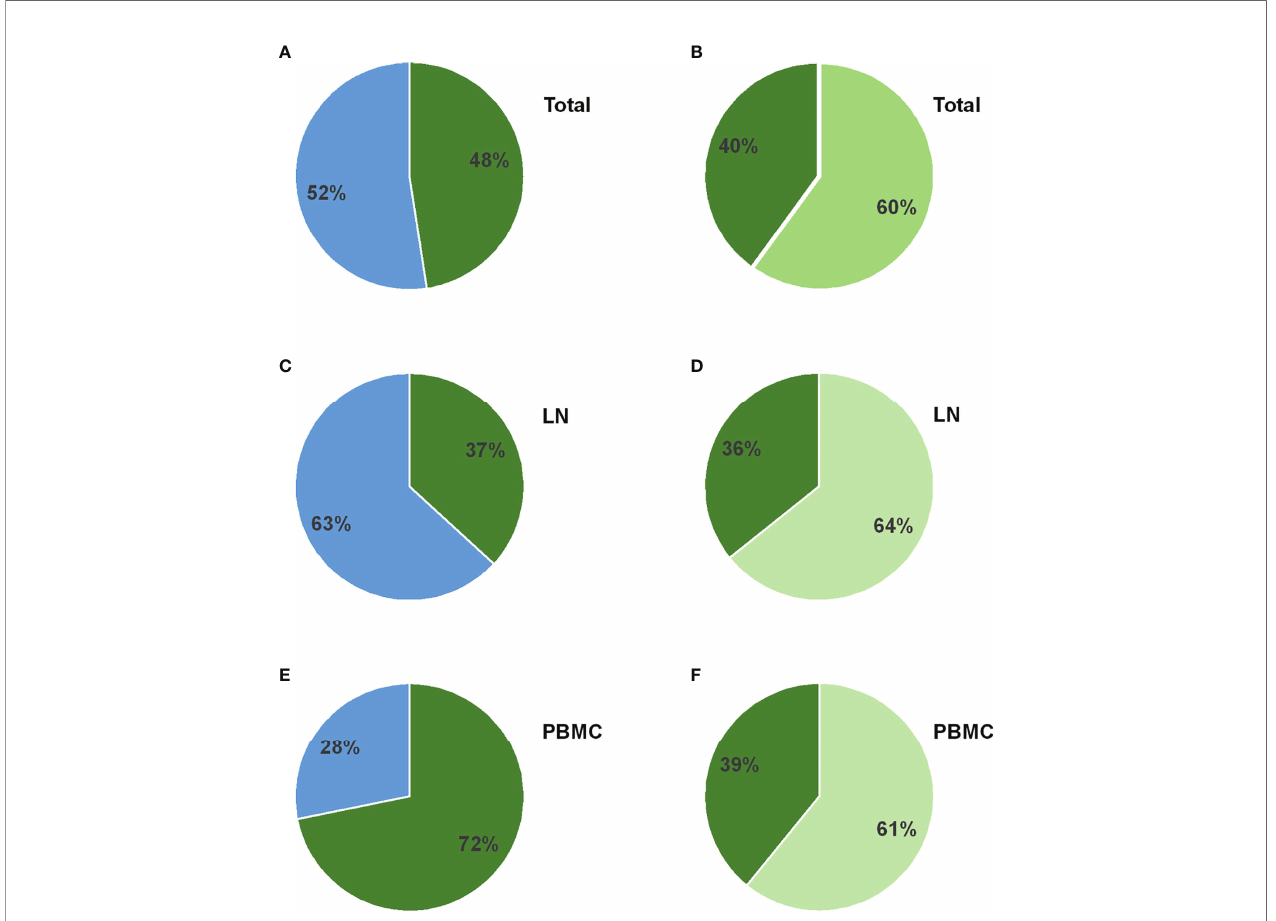
FIGURE 2 | Gag mutations unique to the reservoir in replication-competent viruses encoding gag-protease from the reservoir. (A – B) The pie chart in panel (A) depicts the proportion of amino acid mutations unique to the reservoir, when compared to the pre-therapy plasma, that are present in the replication competent recombinant viruses encoding the patient-derived gag-protease from the lymph node (LN) and peripheral blood mononuclear cell (PBMC) reservoir. This proportion is shown in green, while the proportion of amino acid mutations unique to the reservoir that were not represented in the virus outgrowth are shown in blue. Of the unique mutations that were present in the virus outgrowth, panel (B) shows the proportion that are in or within 5 amino acids of CTL epitopes restricted by the patient HLA-I alleles (shown in light green), versus the proportion that were not in these epitopes (shown in darker green). (C – F) Panels (C) and (D) are speci fi c to the LN reservoir only and panels E and F are speci fi c to the PBMC reservoir